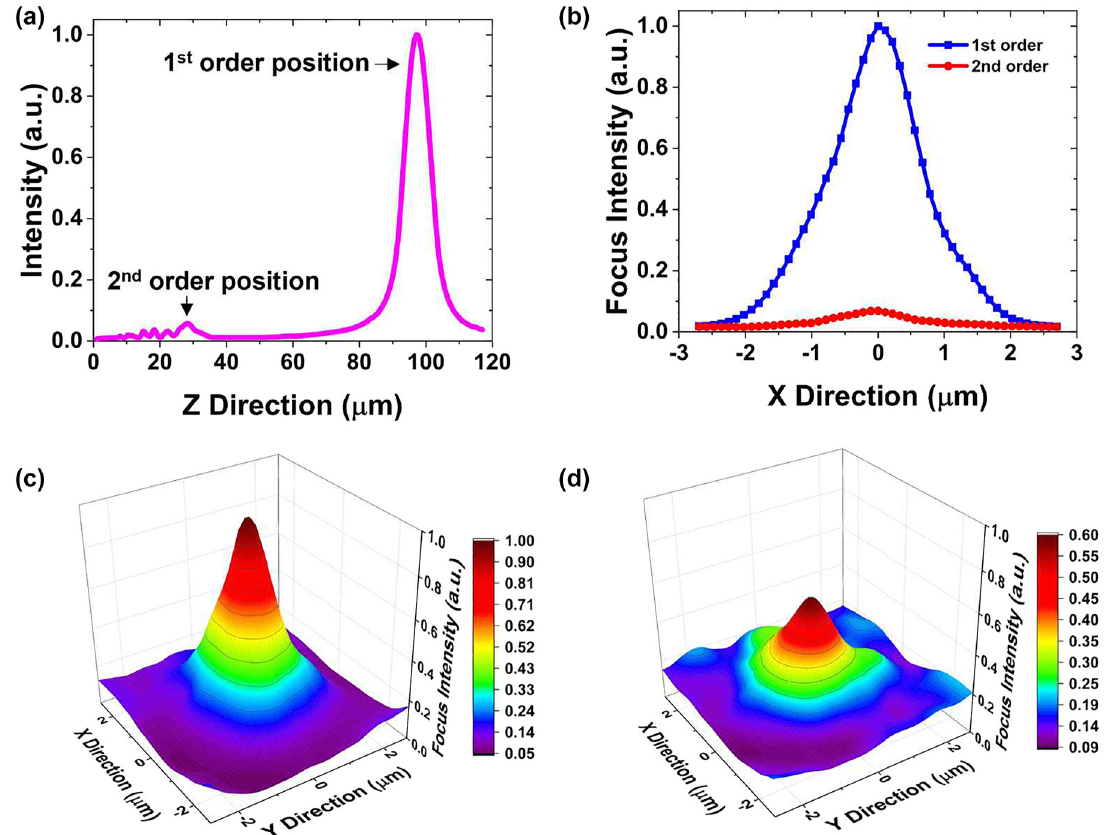
Figure 5: Comparison of the focusing properties at first- and second-order focal positions. (a) Numerically calculated intensity distribution along the central axis of the FZP, clearly indicating the first- and second-order focal positions. (b) Measured lateral intensity distributions at the first- and second-order focal positions. The intensity profile of the second-order focus via gate biases of (c) + 1.8 V and (d) − 1.8 V. Table 1: Summary of the performance of the FZP-type flat lenses fabricated with emerging low-dimensional materials.